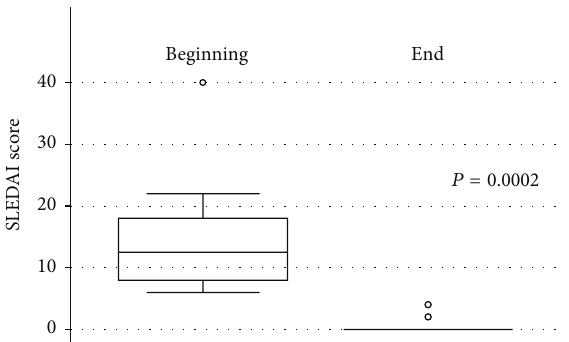
Figure 1: Box plot diagram of the SLEDAI score at the beginning and at the end of the last cycle of